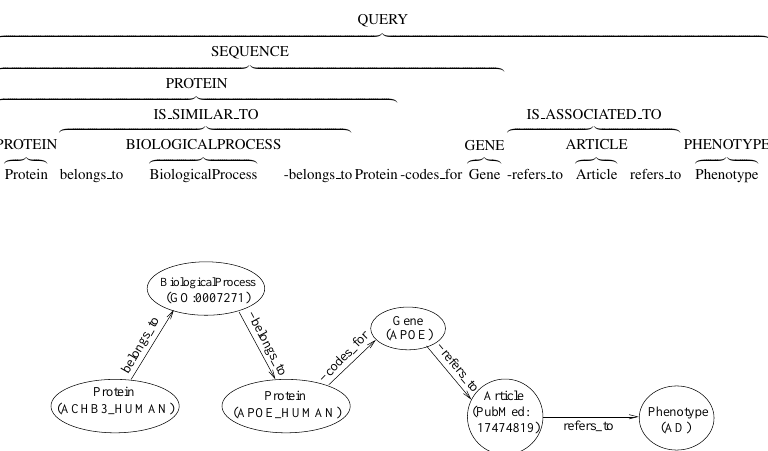
Figure 3: An example illustrating a parse tree for a path type matching a path in the graph